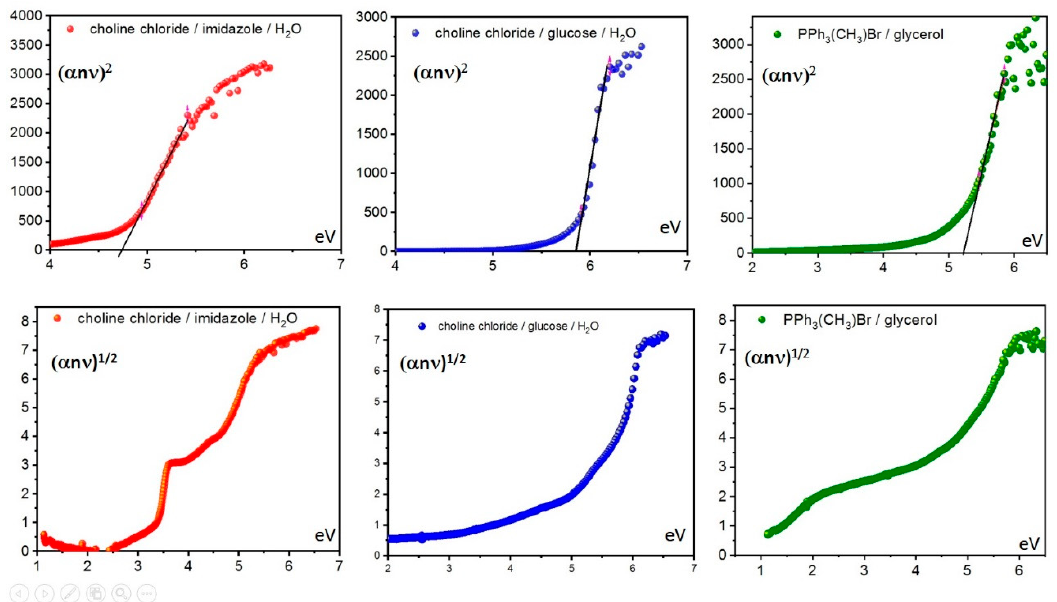
Figure 4. Tauc plots for (top) direct and (bottom) indirect transition of Systems (left) 2 , (center) 3 , and (right) 6 .